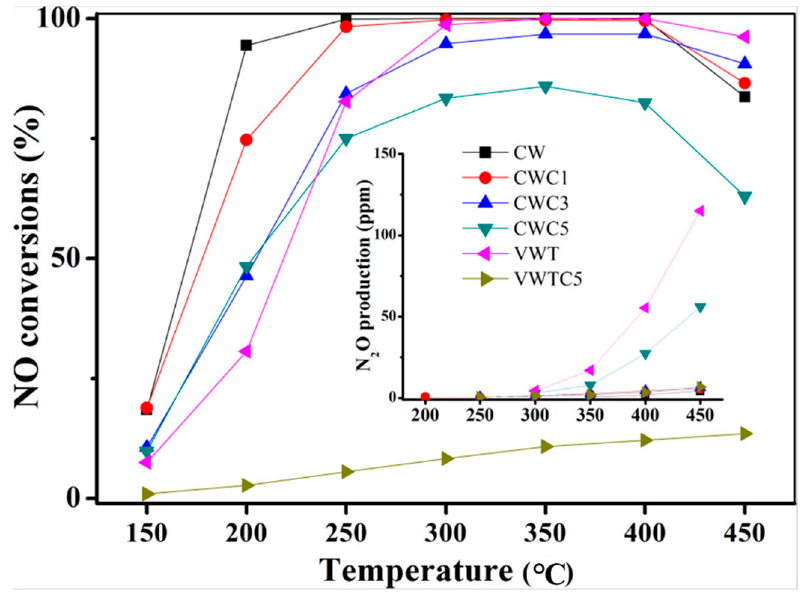
Figure 8. NO conversion and N 2 O production of CW, VWT and Ca poisoned catalysts. Reaction condition: catalyst amount = 0.1 g, [NO] = [NH 3 ] = 500 ppm, [O 2 ] = 3%, N 2 balance, total flow rate = 200 mL/min, GHSV = 120,000 mL/(g · h) [58].